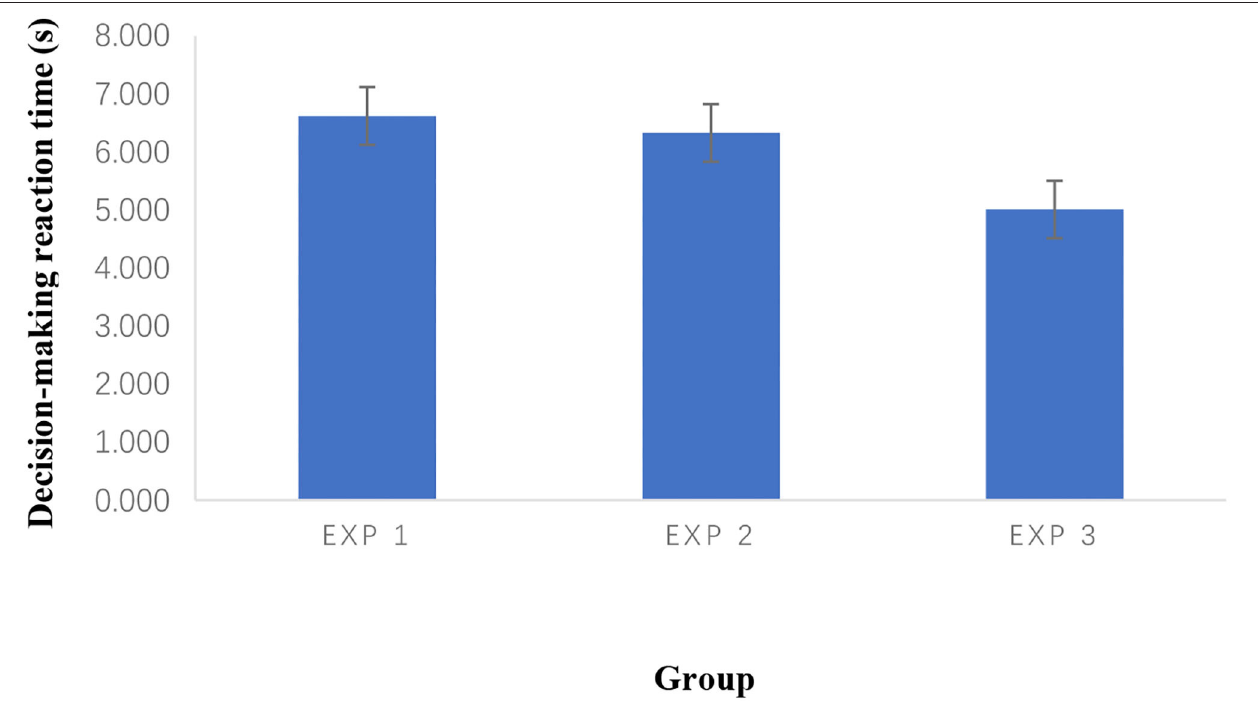
FIGURE 6 | The mean of reaction time at